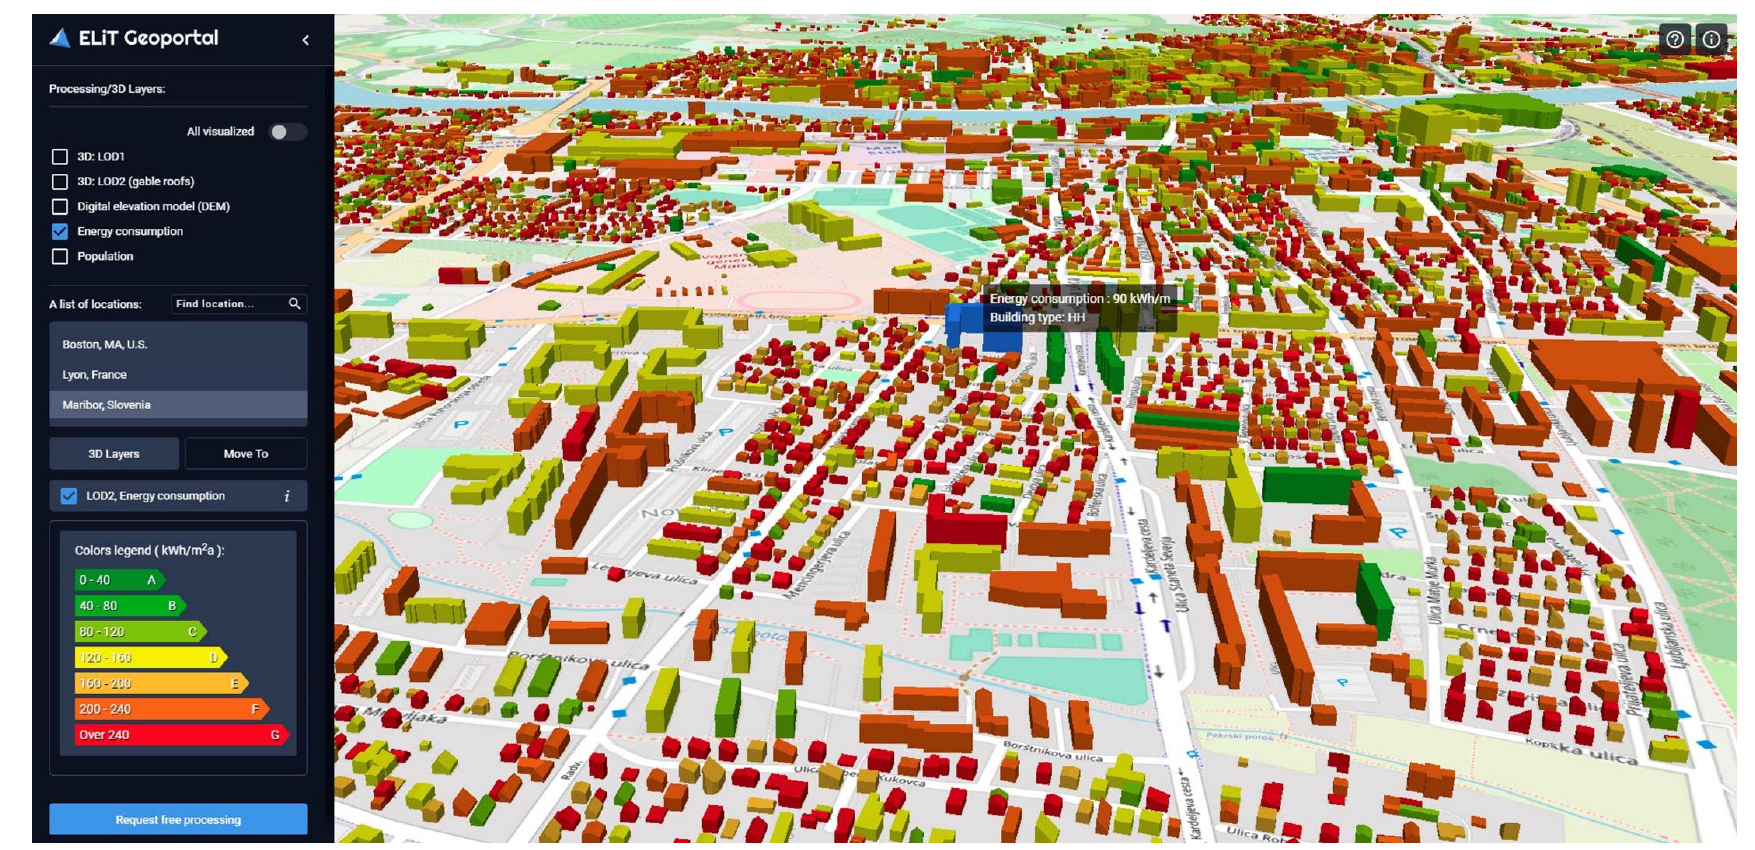
Figure 10. A fragment of a whole urban area of the city of Munster, Germany, presented on the Geoportal as 3D City GML LOD1 models with the implemented use case of estimation of energy consumption by buildings.